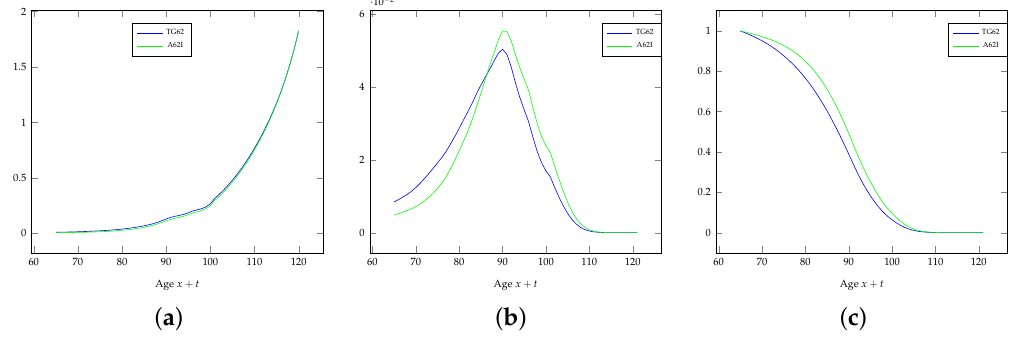
Figure 1. Comparison between the life tables TG62 and A62I (force of mortality, probability density function of T 65 , survival function). ( a ) Force of mortality µ x ; ( b ) Probability density function f 65 ( t ) ; ( c ) Survival function S ( x )